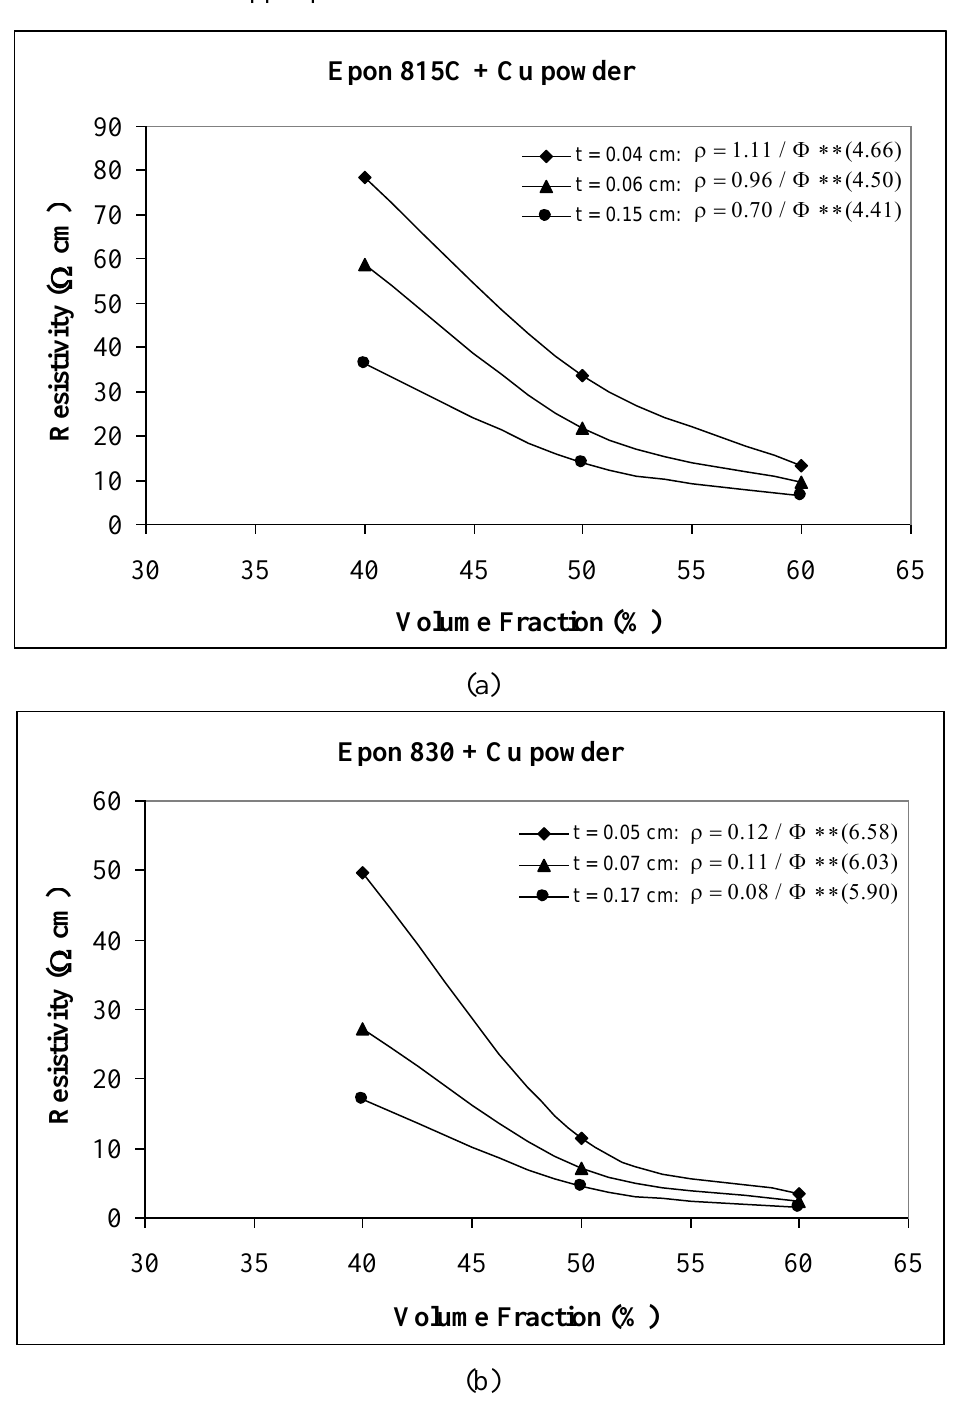
Figure 17. Volume fraction-thickness dependent resistivity of Epon 815C ( a ), and 830 ( b ) films filled with etched copper